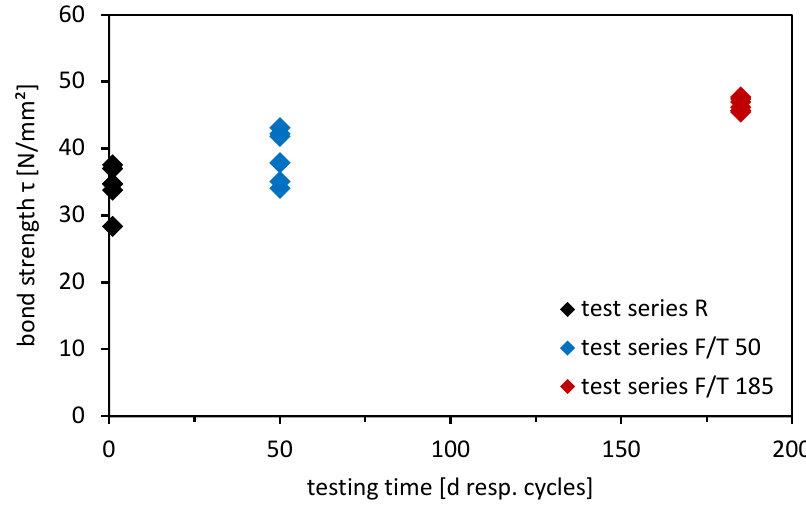
Figure 8. Determined bond strength values τ as a result of the measured residual load capacities in the different test series.